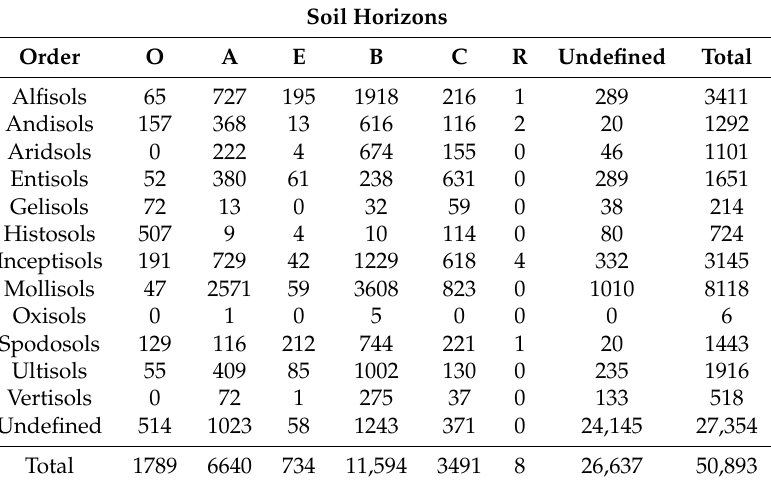
Table 2. Distribution of samples in the NSSC KSSL MIR library as a function of soil order and